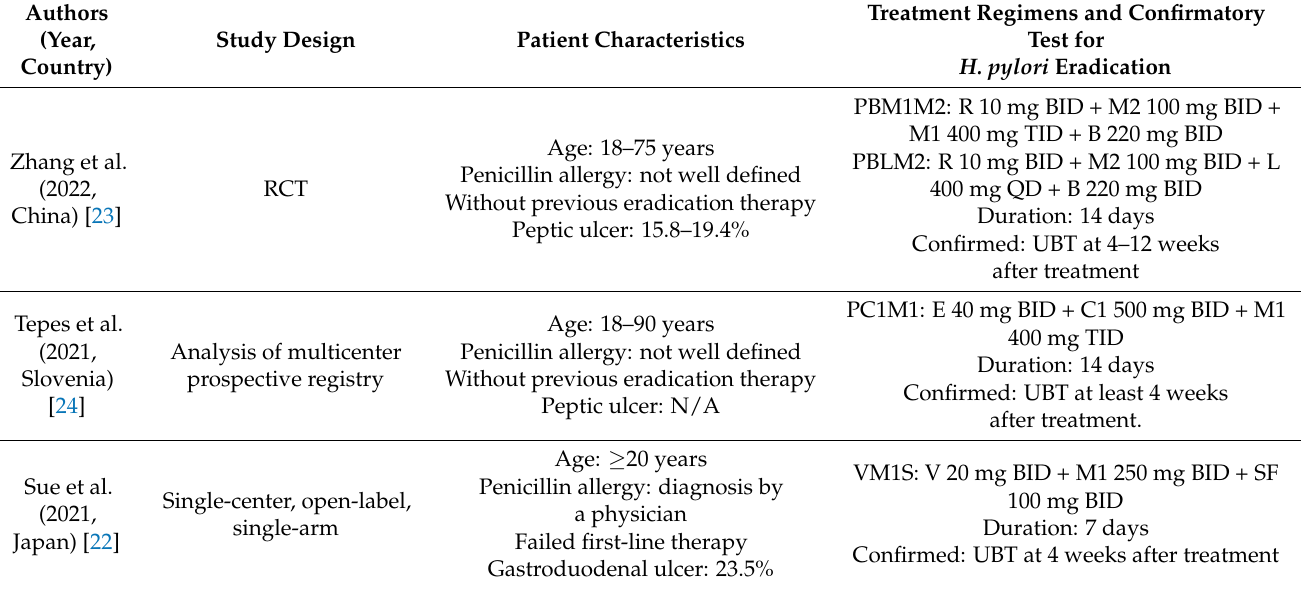
Table 1. Characteristics of included